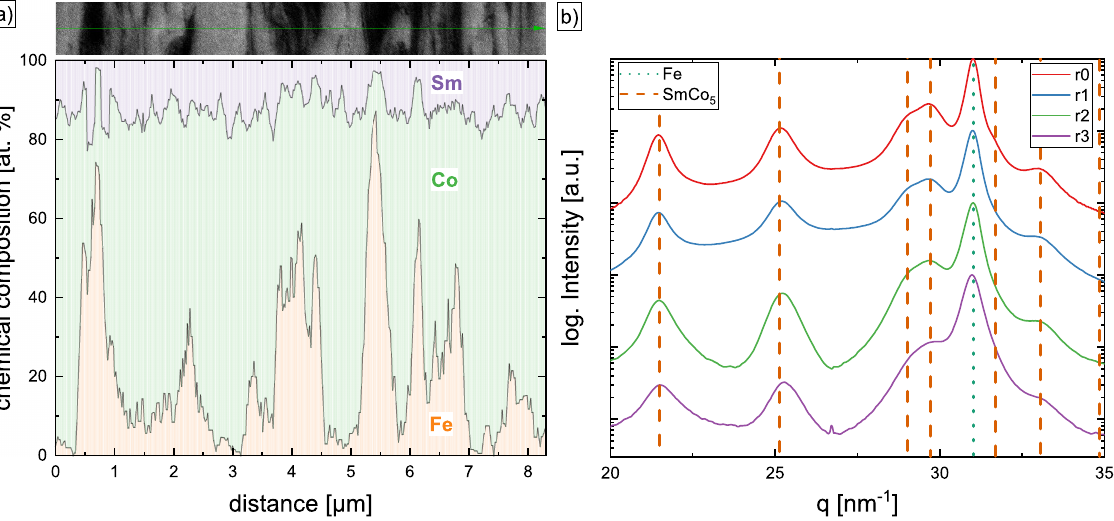
Figure 4. ( a ) EDX line-Scan at r3 in axial direction for the 47 wt.% Fe–53 wt.% SmCo 5 sample shown in Figure 2. The alternating Fe content represents the two-phase microstructure. ( b ) Synchrotron XRD measurements of the RT-deformed 47 wt.% Fe–53 wt.% SmCo 5 sample for different